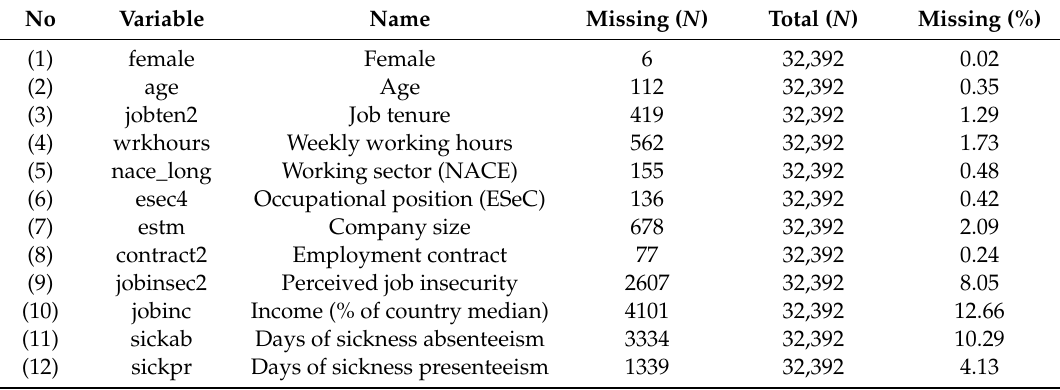
Figure A1. Distribution of health events and presenteeism propensity in the EWCS 2015. Table A1. Absolute and relative frequencies of missing values before imputation.